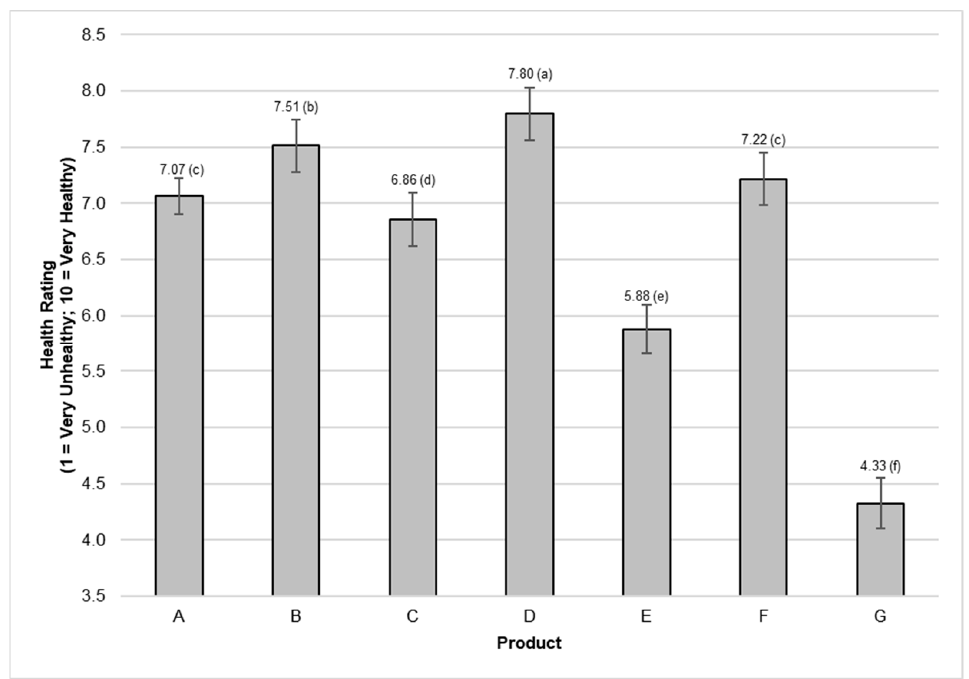
Figure 4. Label ratings for fictitious cereal product with different FOP labels. Product A: control; Product B: high Health Star Rating; Product C: Guideline Daily Amount with a ‘less healthy’ nutri- tional profile; Product D: endorsement logo/low Glycemic Index claim; Product E: low Health Star Rating; Product F: Guideline Daily Amount with a ‘healthy’ nutritional profile; Product G: warning. Differences with a significance level of 5% ( p < 0.05) were considered statistically significant and are indicated by different alphabetical letters on the graph (a-f).